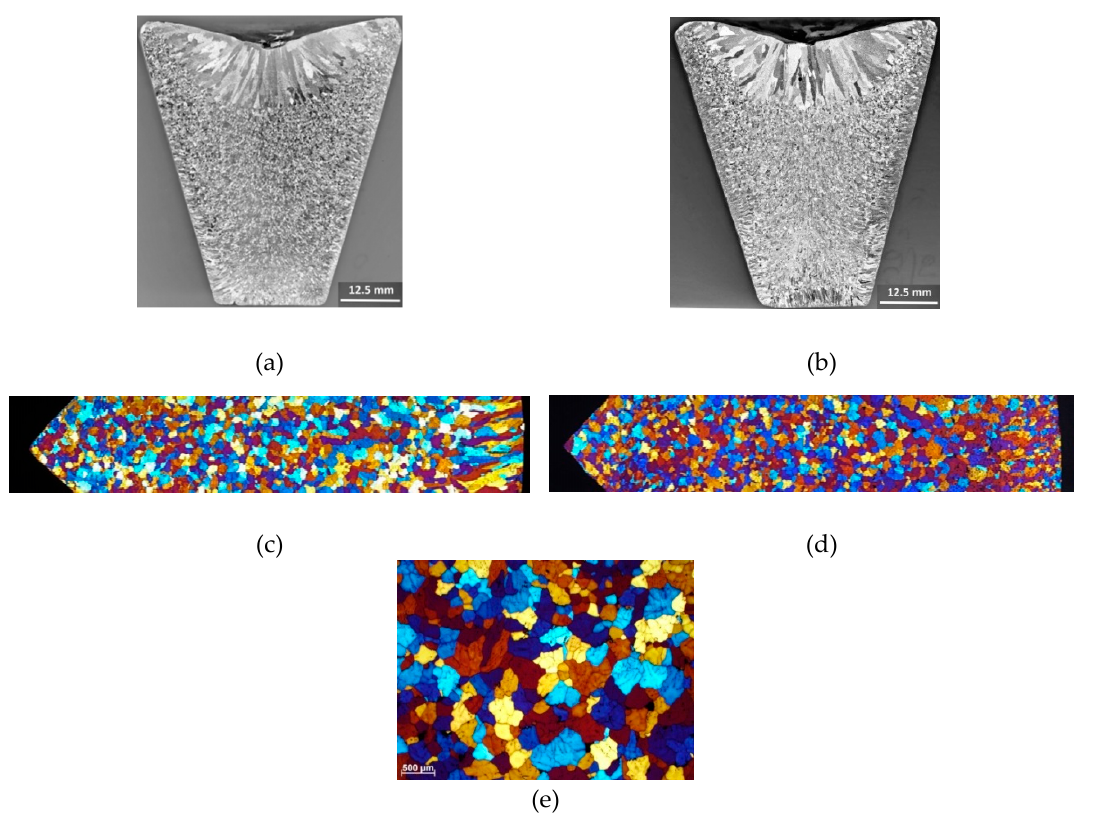
Figure 3. Effect of rod introduction into the melt in the temperature range 720 to 670 °C ( a , c ) and 710 to 670 °C ( b , d , e ) on the grain structure of the alloy cast in a TP1 mould.